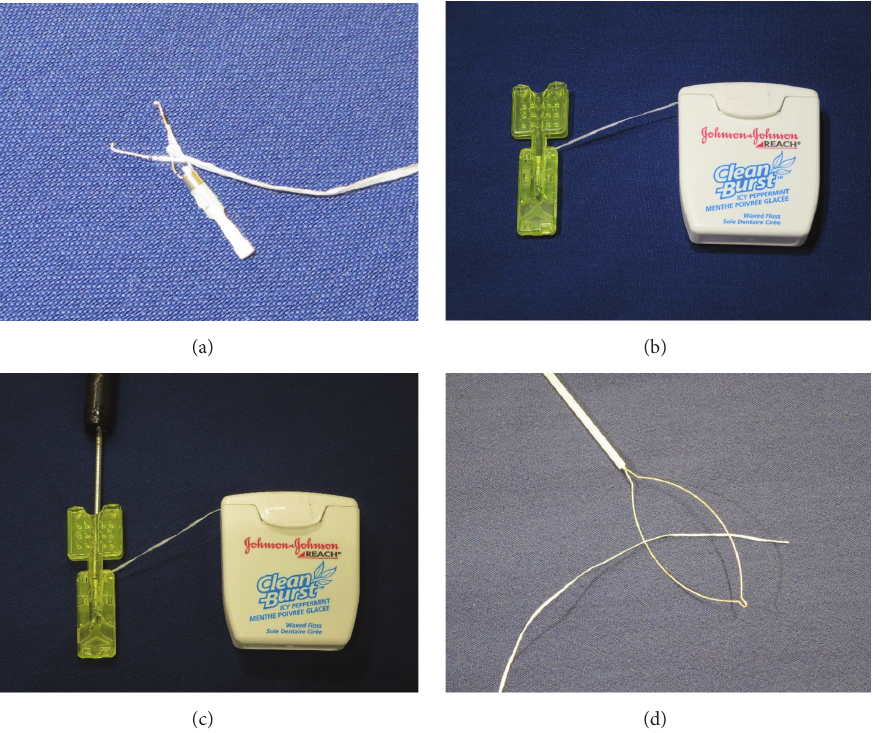
Figure 1: Preparation for thread-traction using a sheath of polypectomy snare (part 1). One end of a thread is tied to the claw of a clip (a), and the clip with the thread is reinstalled into the clip case (b). After the rotatable clip-fixing device is inserted into the channel of the endoscope, the clip with the thread is attached to a rotatable clip-fixing device (c). The other end of the thread is passed through the loop of a polypectomy snare (d).